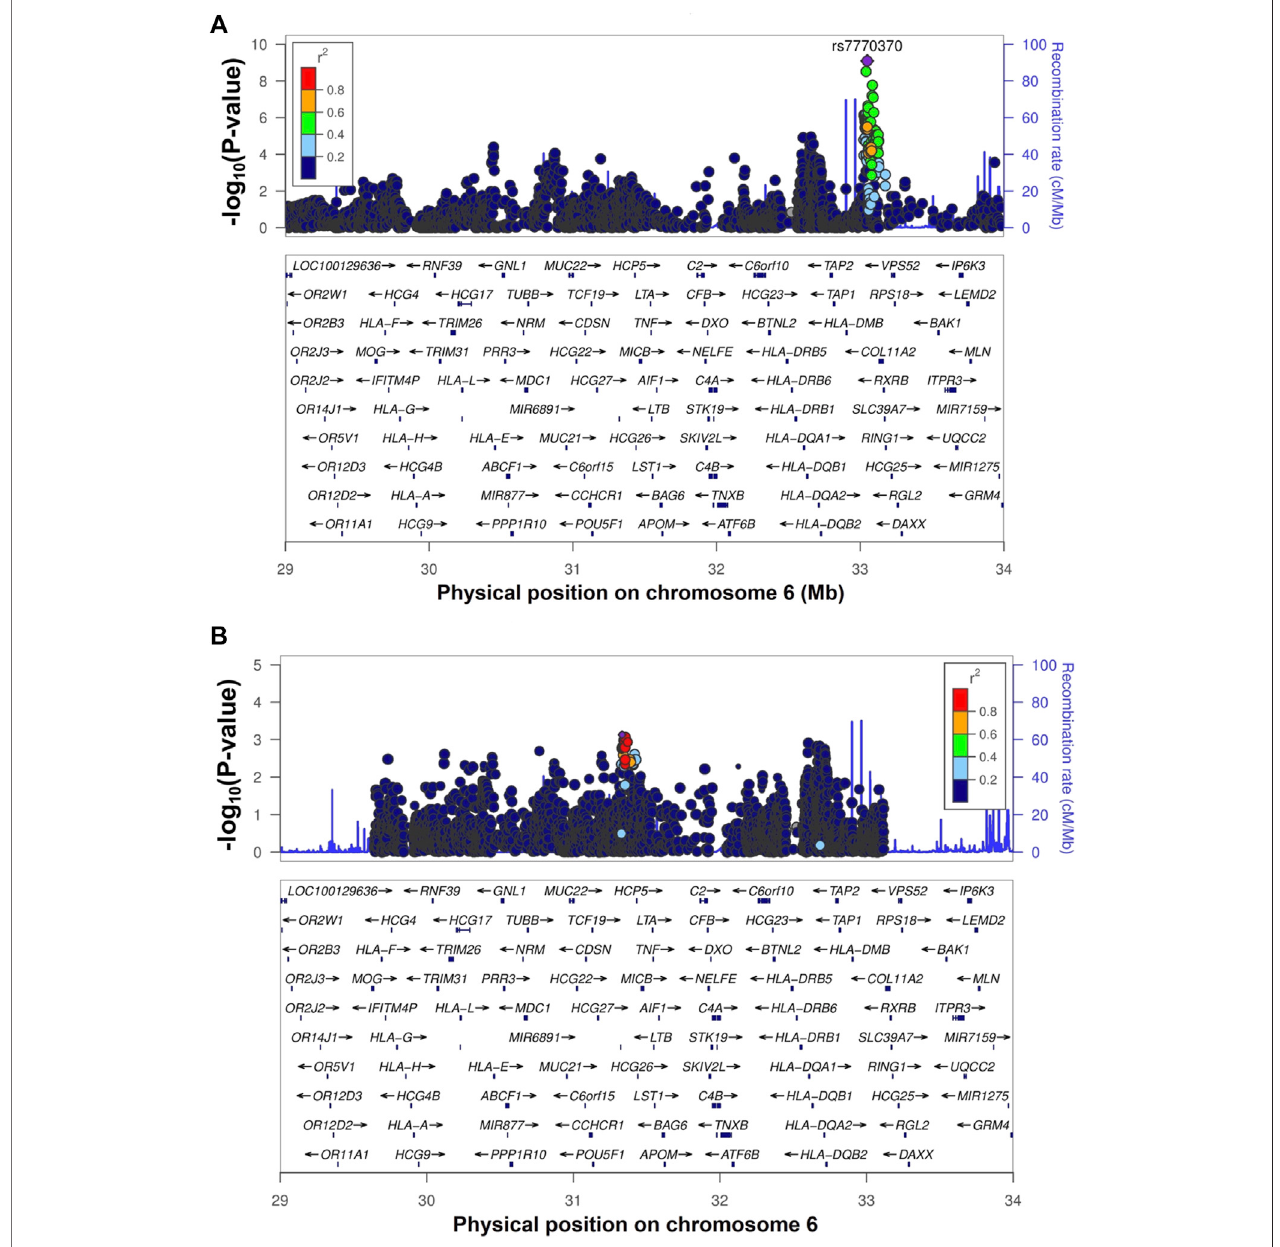
FIGURE2| Theregionalassociationplotforthe HLA-DPA1/DPB1 region.Figure (A) showstheregionalassociationplotofthe HLA regionwiththeGWAStopSNP (rs7770370) shown by a purple circle. Figure (B) shows the plot of the HLA-DPA1/DPB1 region after conditioning on the top SNP (rs7770370).